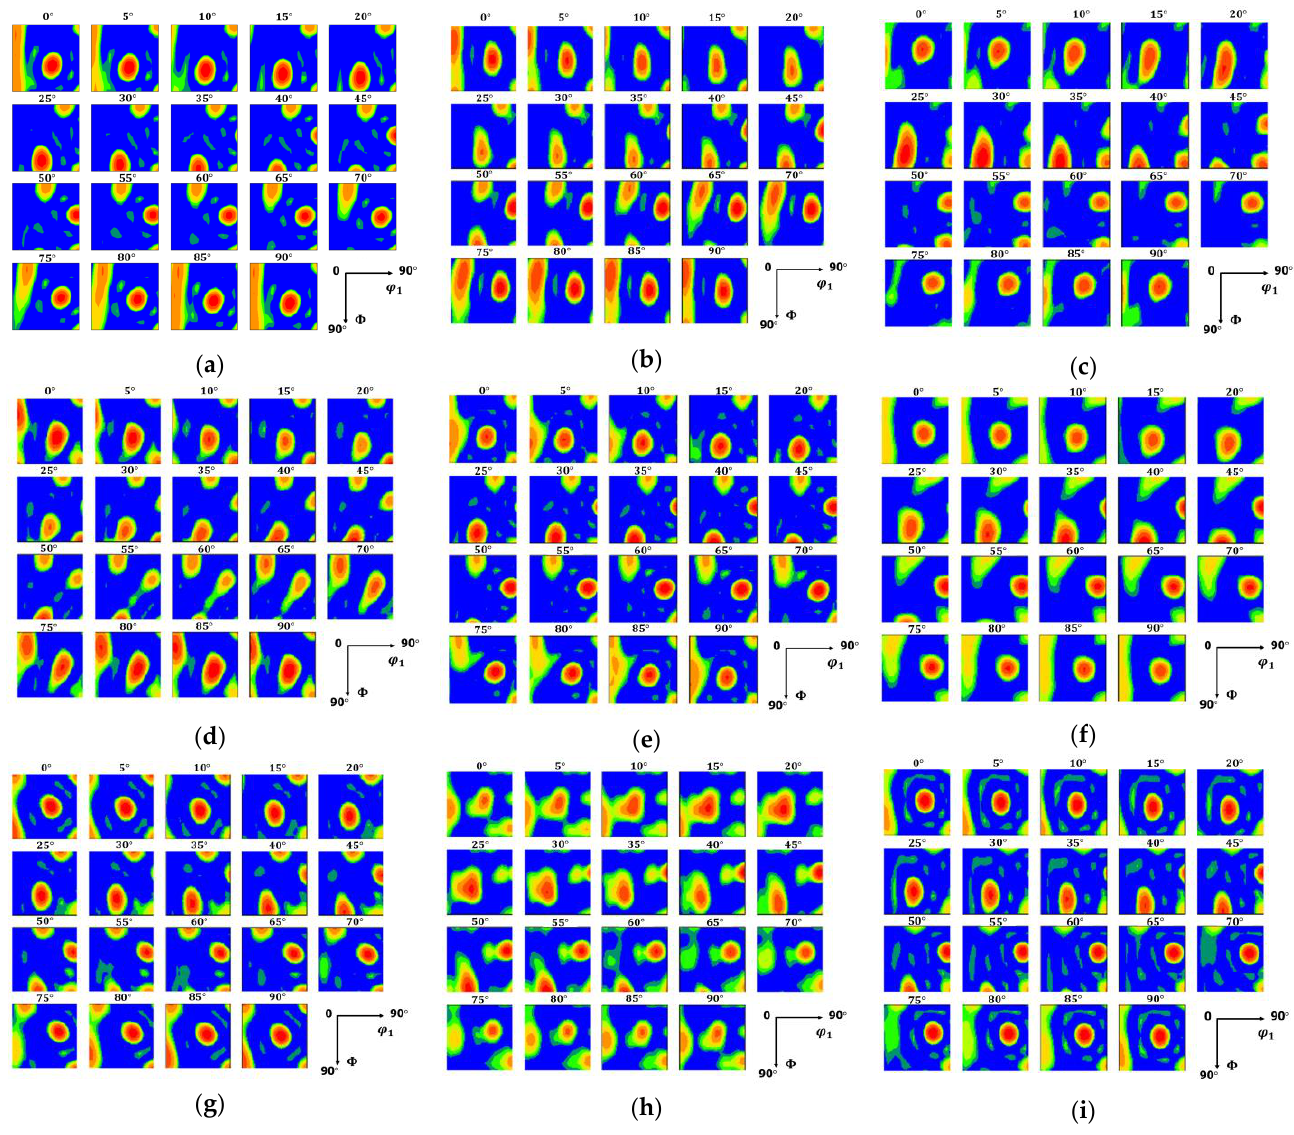
Figure 12. The experimentally determined ODF diagram after hot compression deformation. (The subgraph captions ( a – i ) correspond to the experimental groups (1) to (9) in Table 2, respectively).